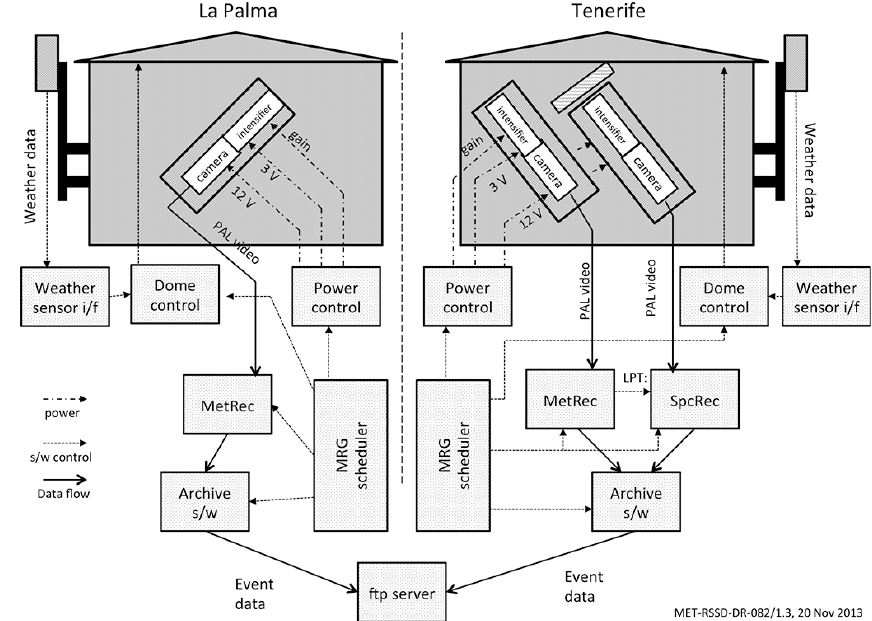
Fig. 6. CILBO block